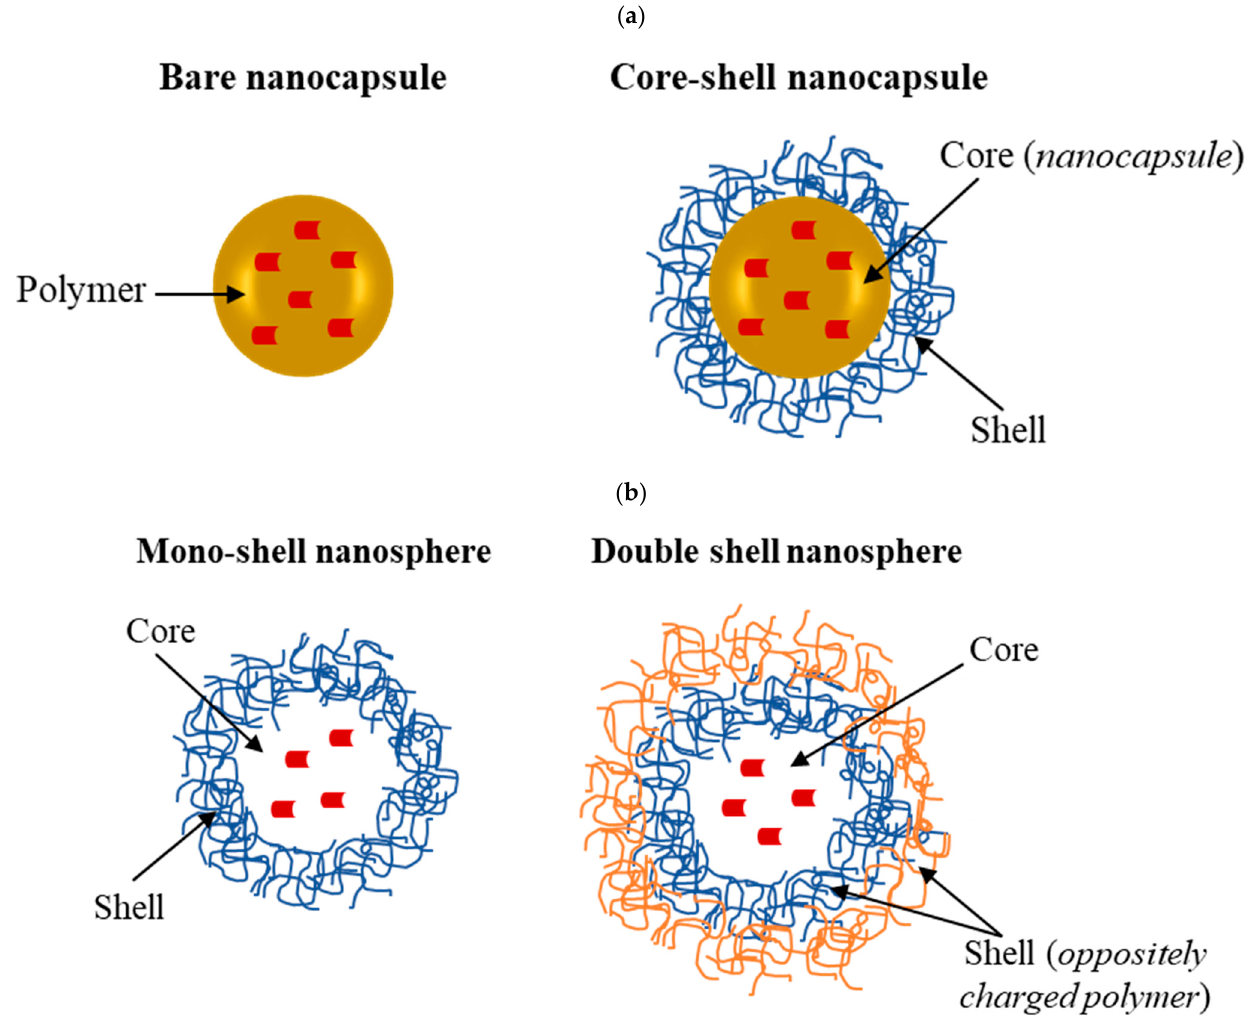
Figure 4. ( a ) Nanocapsules and ( b ) nanospheres.